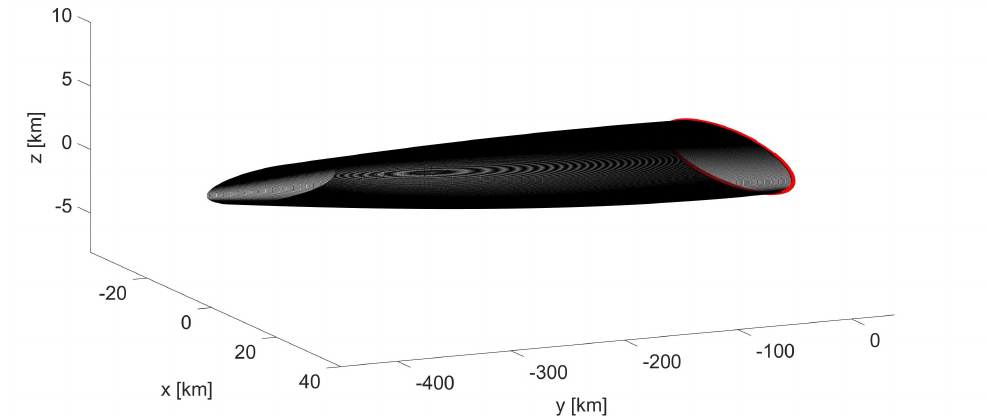
Figure 2. SSO formation: trajectory (black) in F r resulting from non-invariant initial conditions; the first orbit is plotted in red.